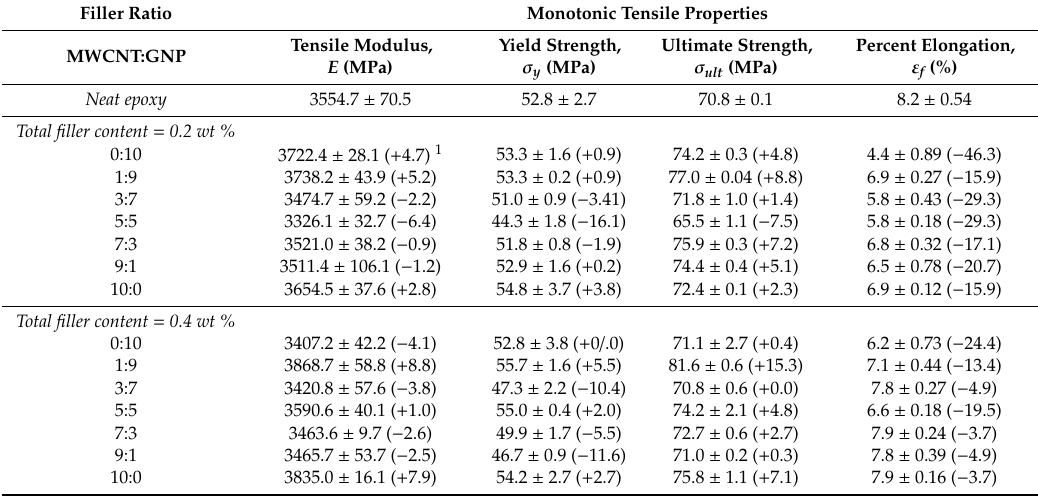
Table 1. Experiment results of monotonic mechanical properties for the nanocomposites with di ff erent filler